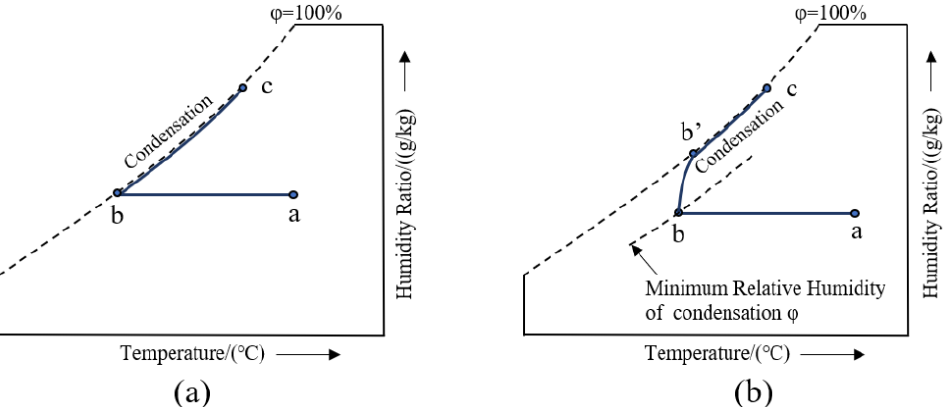
Figure 1. Condensation process of air in psychrometric chart: ( a ) saturated condensation model; ( b ) unsaturated condensation model. Where φ is relative humidity.